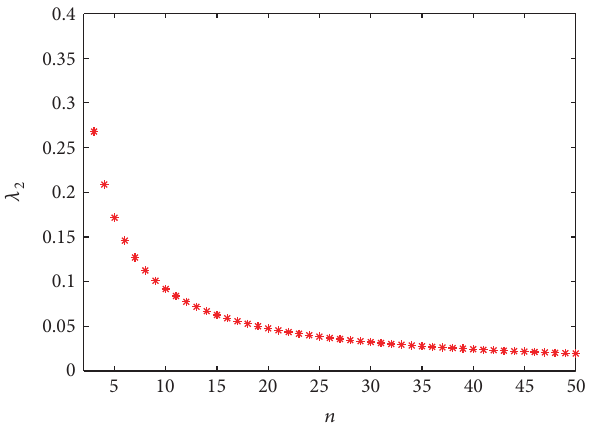
Figure 17: 𝜆 2 of 𝑆 𝑛−1 ∘ 𝑃 𝑛−1 ( 𝑛 ≥ 3 , 𝑘 = 𝑛 − 1 ).